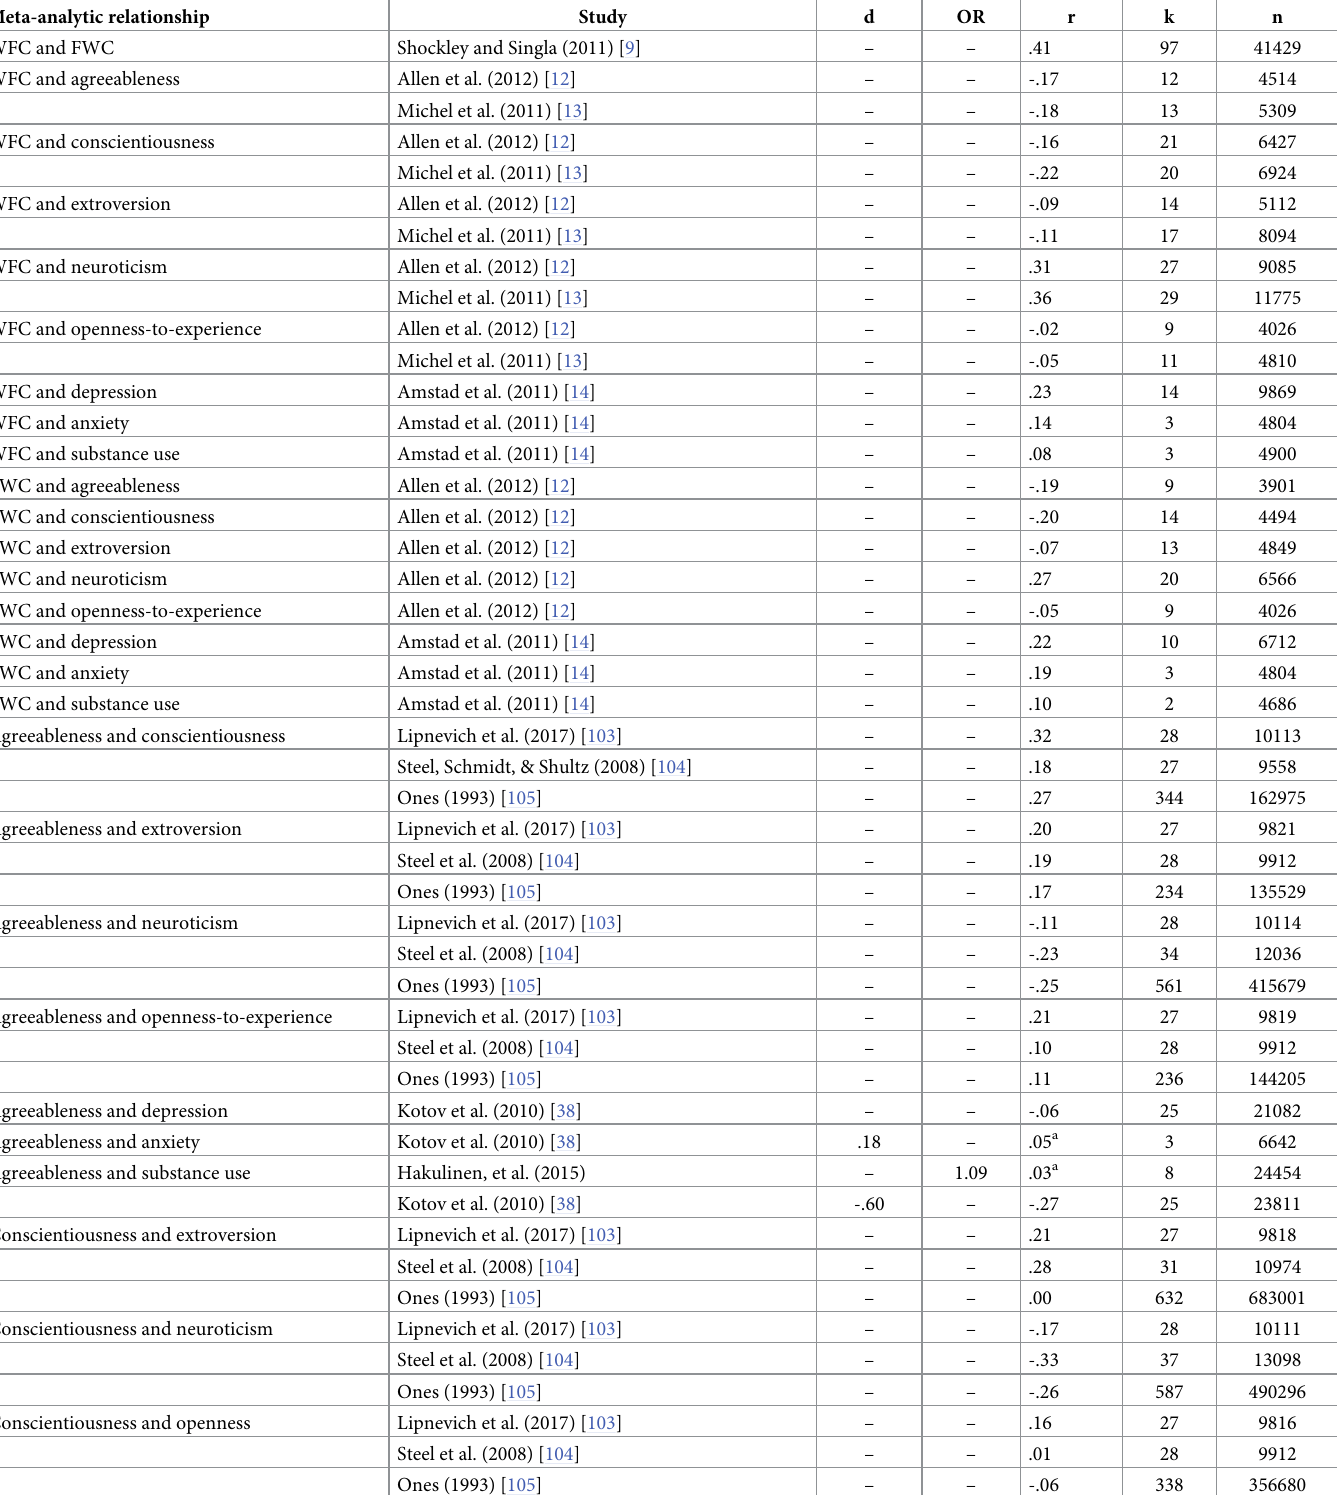
Table 1. Effect size coding from published